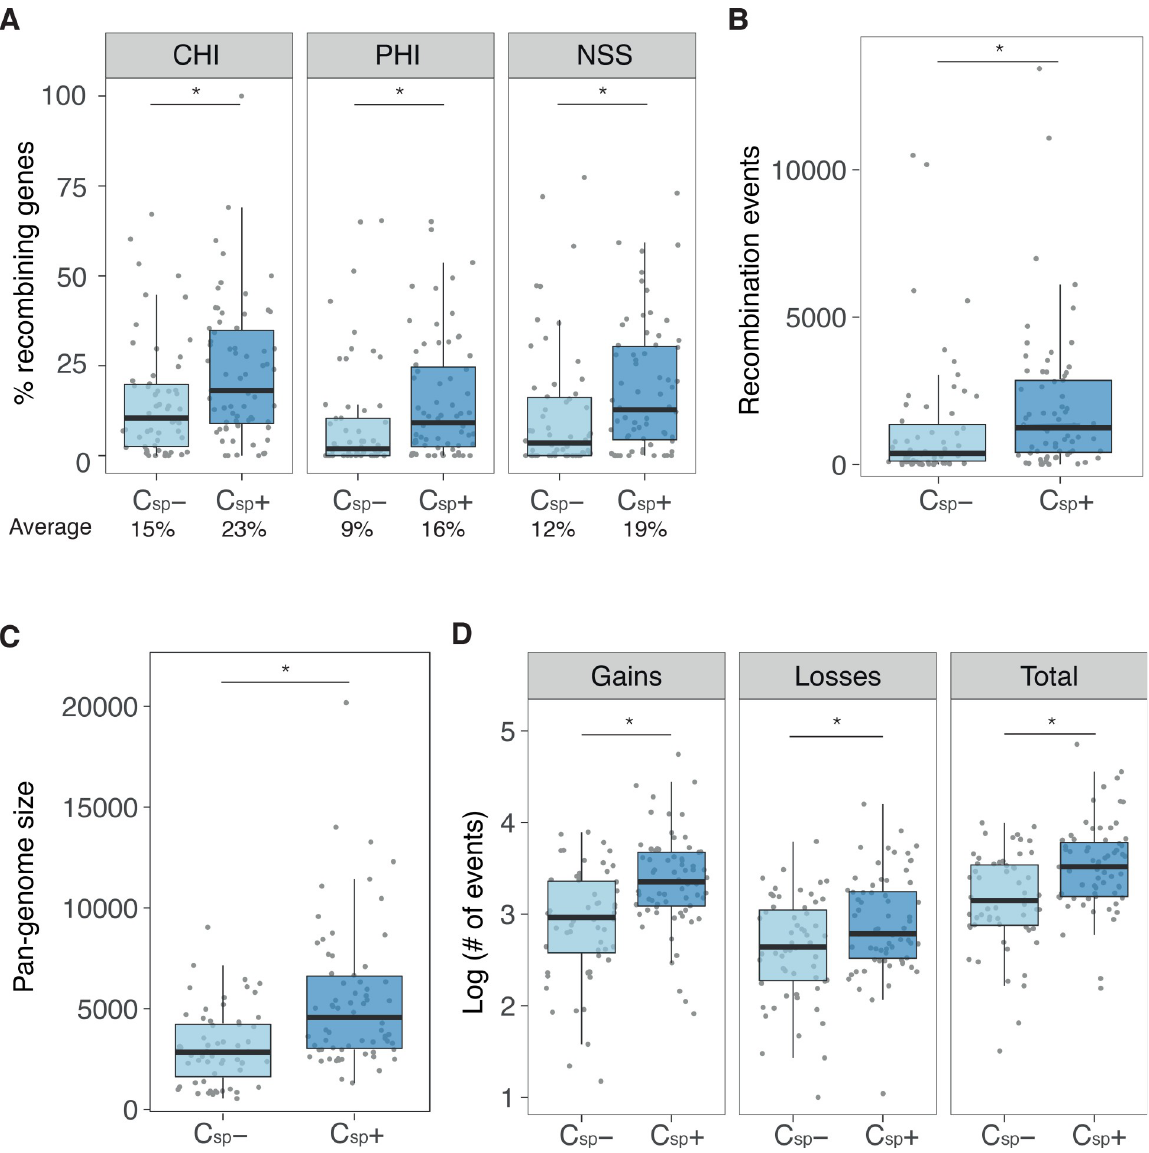
Fig 1. Gene exchange in bacterial species is higher in species coding for capsules. A . Percentage of genes for which the null hypothesis of no homologous recombination was refuted by PHI program as measured by excess polymorphism (CHI), by phylogenetic incongruence (PHI) and by neighbour similarity score (NSS). Species with capsules are designated as C sp +, N = 68; species without capsules are grouped as C sp -, N = 59. Percentage at the bottom of the panel indicates the average percentage of recombining genes. The median is highlighted by the boxplot. B . Number of recombination events as inferred by ClonalFrameML. C . Comparison between species with and without capsule in pan-genome size expressed as the number of gene families. D . Horizontal gene transfer events as inferred by Count. Events are log 10 -transformed for visual purposes. See S1 Table for the details on the statistical tests. � P < 0.05, GLM. Points represent individual species, and dispersion along the x-axis was done for visualization